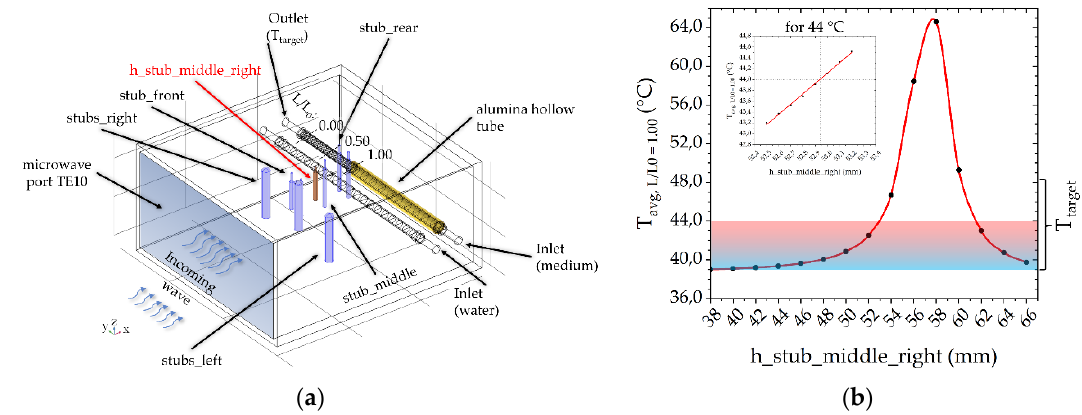
Figure 5. ( a ) 915 MHz cavity with alumina hollow tube (yellow) and stub tuners (blue) with TE10-port. ( b ) Relationship between varied height of h_stub_middle_left (red) and average temperature at outlet, T avg,L/L0 = 1.00 , with the rest of the stub tuners fixed. The marked area describes the temperature range within the experiments between 39 °C and 44 °C.